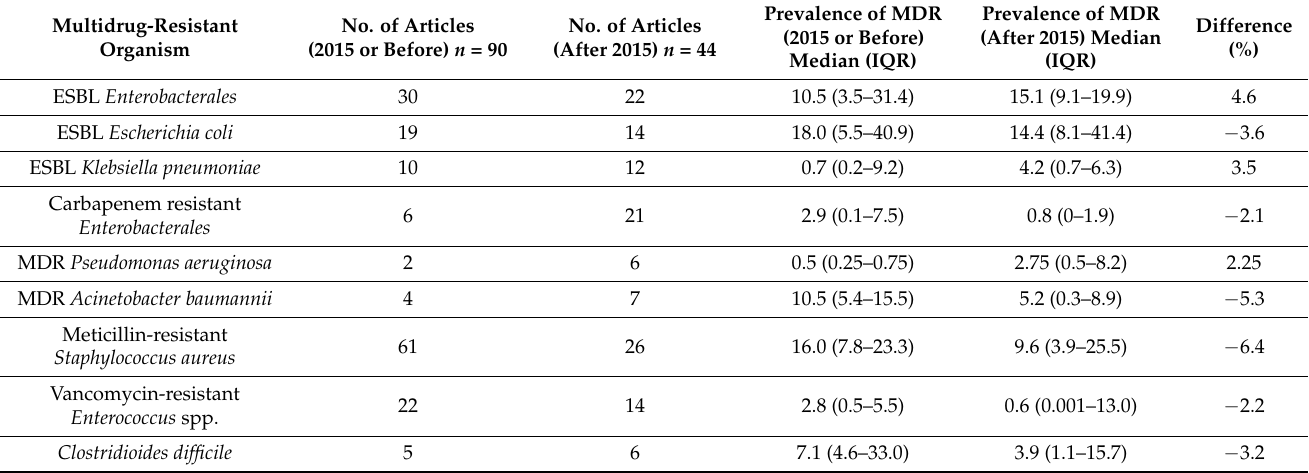
Table 2. Changes in the prevalence of multidrug-resistant organisms, before and after 2015. Multidrug-Resistant No. of Articles Organism (2015 or Before) n =